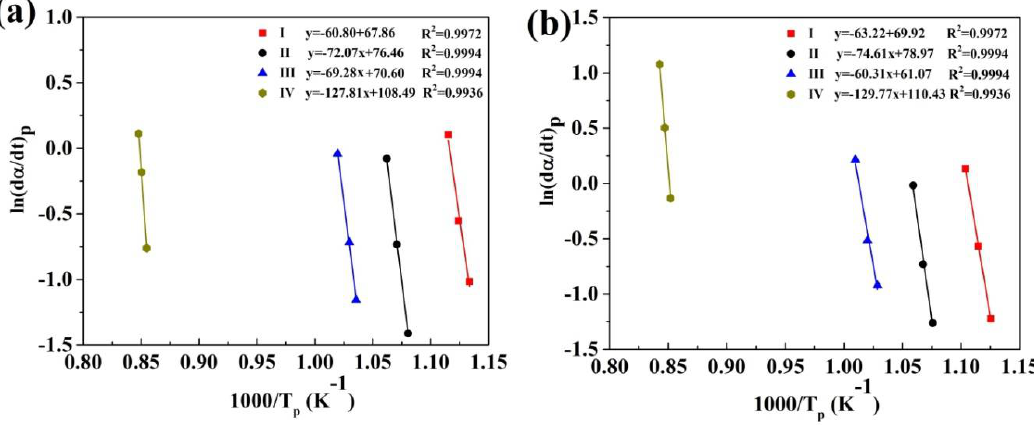
Figure 5. Plots of ln( dα / dt ) p vs. 1000/ T p for all crystallization stages of (Fe 41 Co 7 Cr 15 Mo 14 Y 2 C 15 B 6 ) 100−x Cu x amorphous alloys; where x= ( a ) 0.25 at.%; ( b ) 0.5 at.%.